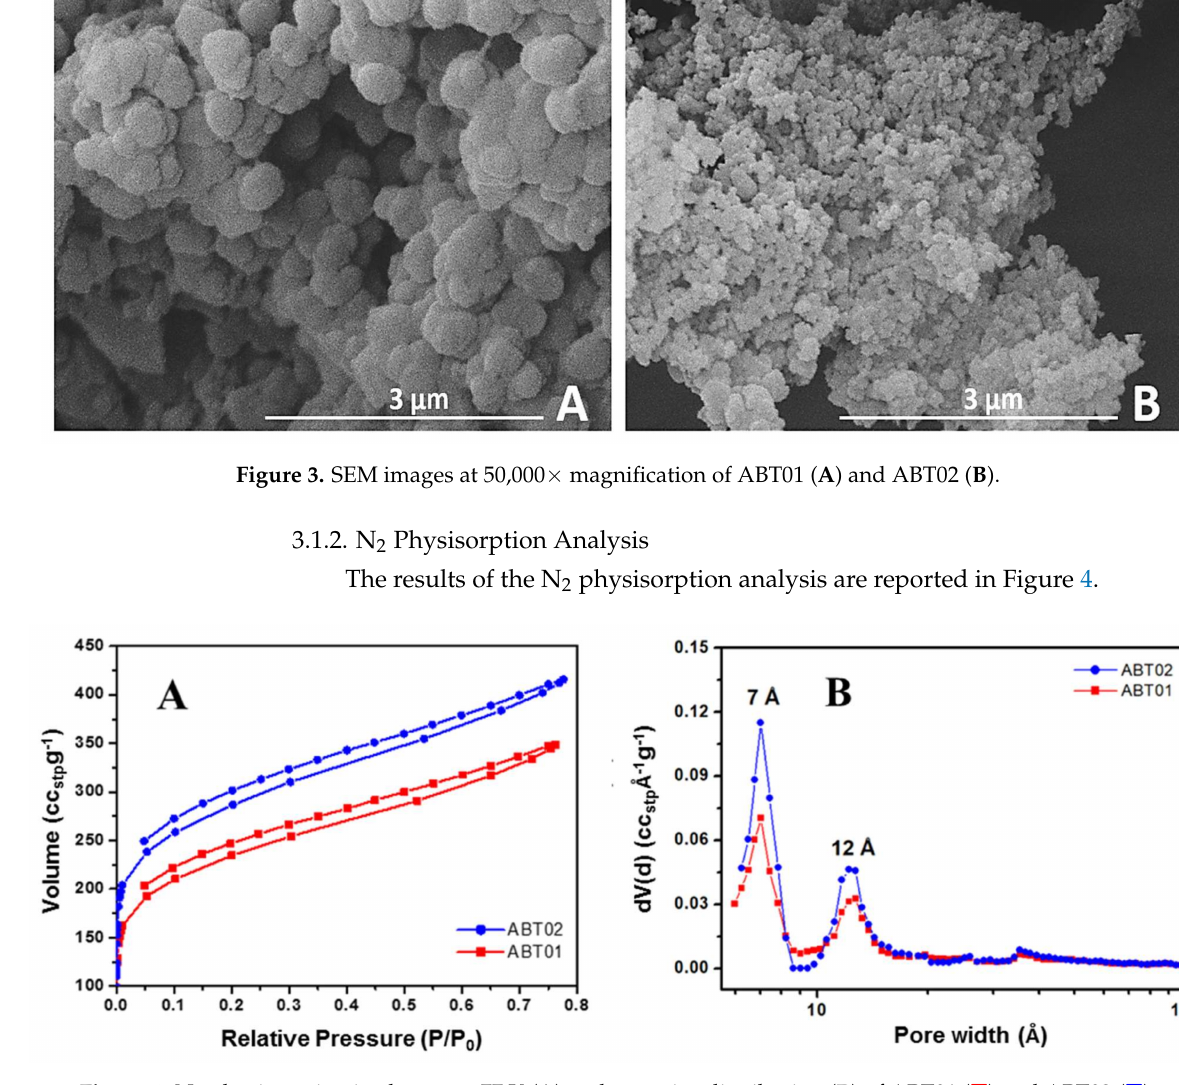
Figure 4. N 2 physisorption isotherms at 77 K ( A ) and pore size distribution ( B ) of ABT01 ( (cid:4) ) and ABT02 ( (cid:4)